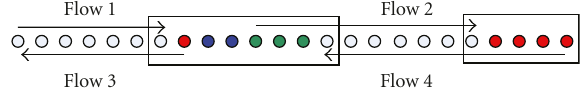
Figure 8: An example of a dual packing, where flow 1 and flow 2 belong to the clockwise unidirectional packing, flow 3 and flow 4 belong to the counterclockwise unidirectional packing. The white nodes are nonresidual nodes, the red nodes are the residual nodes of the clockwise unidirectional packing, the green nodes are the residual nodes of the counterclockwise packing, and the blue nodes are the residual nodes of both the two unidirectional packings. The nodes in the rectangles are the uncommon